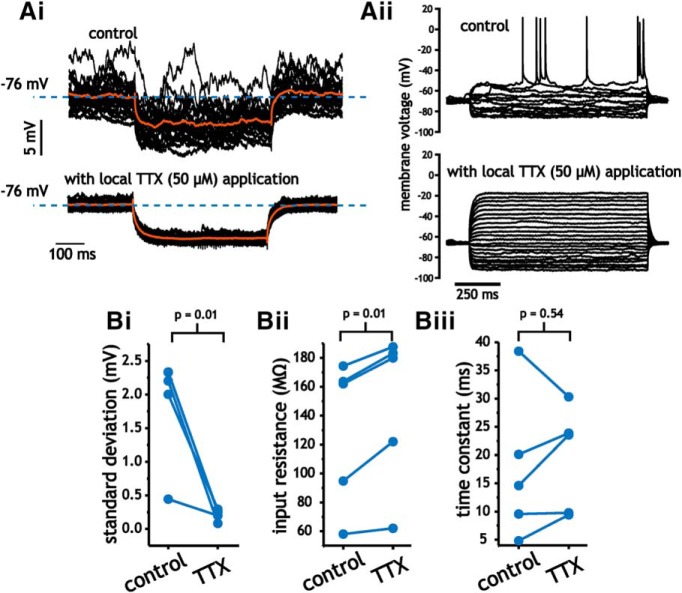
Silencing network activity with TTX minimally impacts average membrane resistance and time constant values measured at rest (−60 to −75 mV). A, Pyramidal cell membrane voltage responses to fixed-size hyperpolarizing current steps in the absence (top panel) or presence (lower panel) of local TTX application. Average response is denoted in red. Note that TTX application was verified by the inability for pyramidal cells to generate spikes at depolarized (>-20 mV) membrane voltages (Aii). B, Comparison of membrane voltage standard deviation (i), membrane resistance (ii), and time constants (iii) from paired data generated before and after application of TTX.